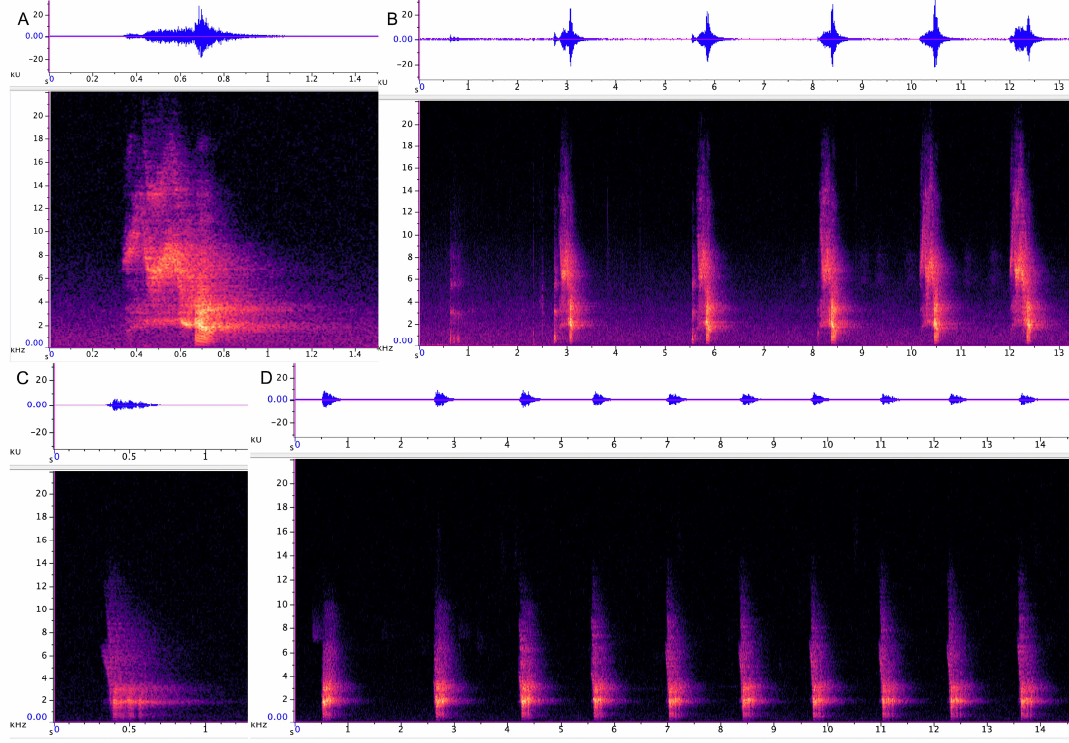
Figure 3. Waveforms (upper images) and spectrograms (lower images) of Dendrohyrax calls. ( A ) Strangled thwack single call. Note frequency-modulated twist that gives the call its name (Sound S3). ( B ) Sequence of strangled thwacks. The image shows the first five (13 s) strangled thwacks of the total of 15 signals in the sequence (duration 45 s) (Sound S4). The first call is not included as it is a small knock that is often used to start or end a sequence. ( C ) Hac call (Sound S5) is less powerful and has a smaller frequency range than the strangled thwack. It sounds like a fast ‘kra-kra-kra’. ( D ) Sequence of hac calls shoving first nine calls (14 s) of the sequence containing 15 signals in the sequence (duration 21 s) (Sound